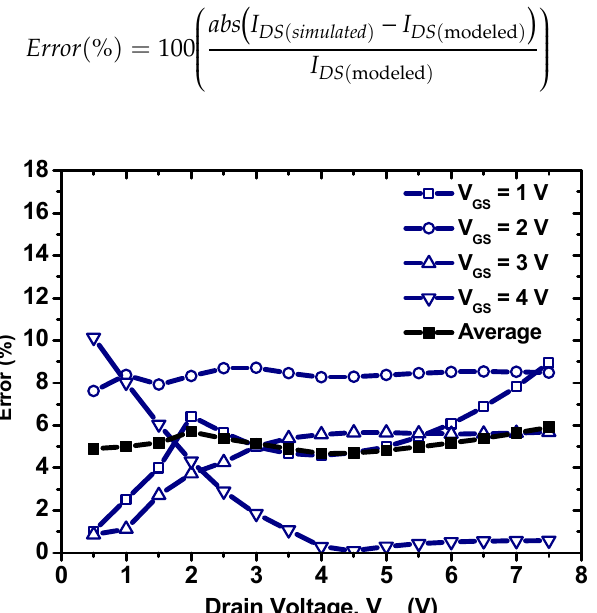
Figure 4. Absolute error computed for each simulated and modeled I DS curve showed in Figure 3 and the average absolute error for all curves.